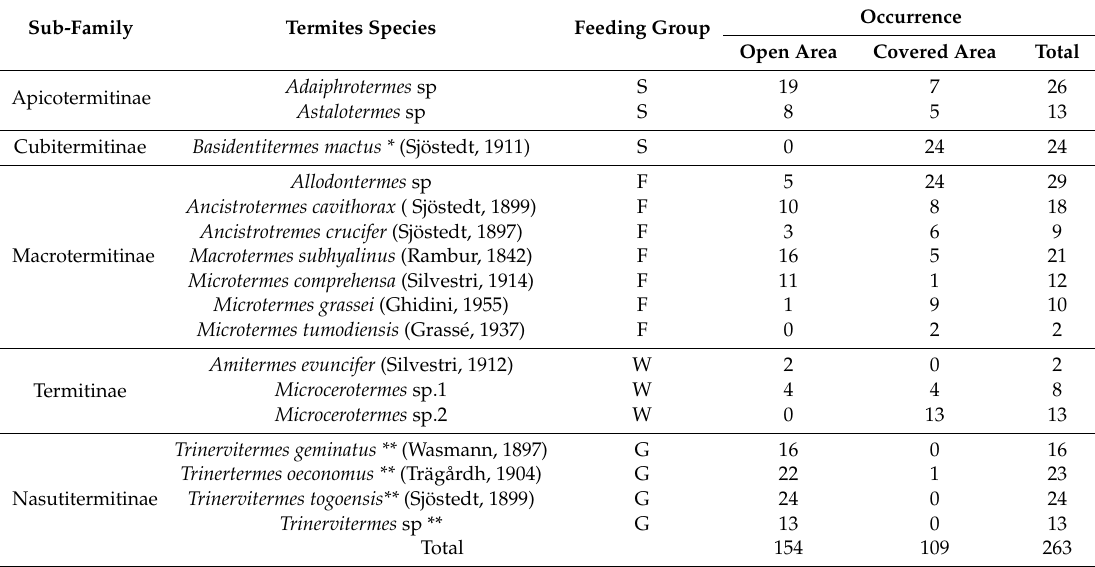
Table 7. Overall occurrence of termites for the two habitats. Potential bio-indicator species for * wooded habitats and ** grass land habitats.